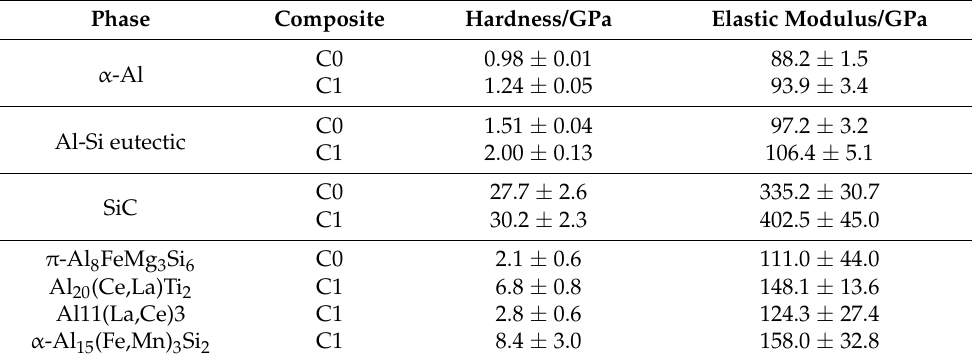
Table 3. Hardness and elastic modulus of phases formed in materials C0 and C1.